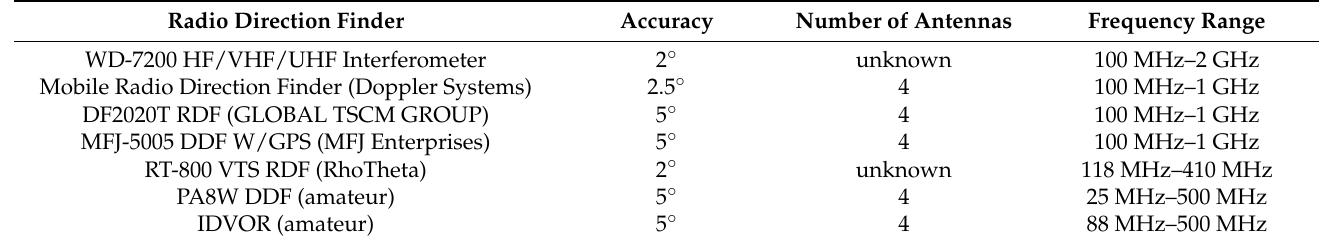
Table 3. Comparison of parameters of commercial and amateur radio direction